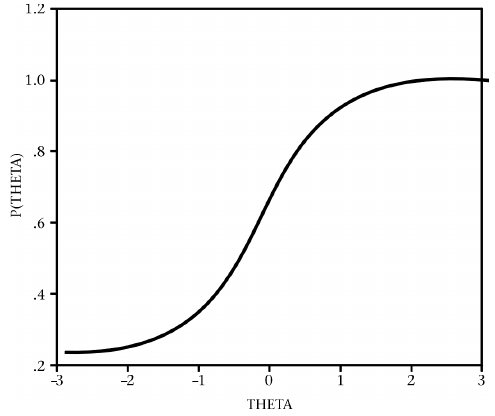
Figure 1: An example of an item characteristic curve